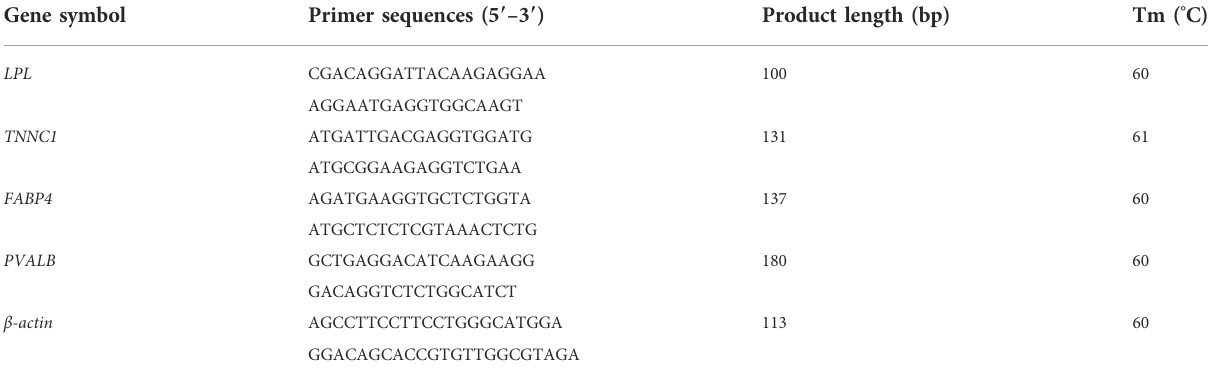
TABLE 1 Primer sequence used for qRT-PCR.